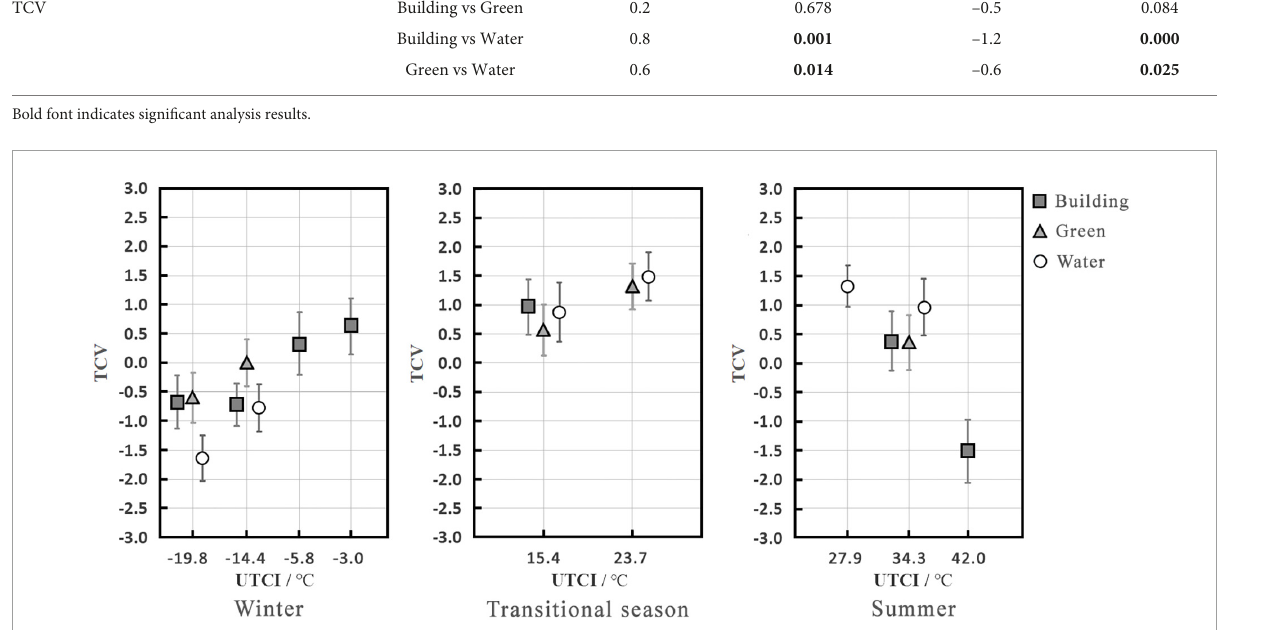
FIGURE4 Mean TCV under different thermal stress levels and between different visual landscapes (abscissa is a categorical variable).